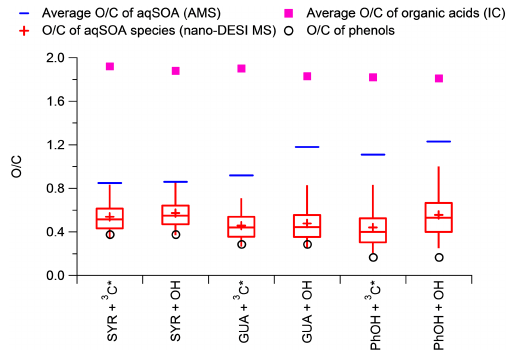
Figure 1. The average O / C ratios of aqSOA formed from the reac- tions of syringol (SYR), guaiacol (GUA), and phenol (PhOH) with 3 C ∗ and · OH, respectively determined by AMS (blue bars) and the average O / C of organic acids determined by IC (pink squares). The distributions of the O / C of individual molecules in the aqSOA de- termined by nano-DESI MS are shown in box plots, in which the whiskers above and below the boxes indicate the 95th and 5th per- centiles, the upper and lower boundaries of the boxes indicate the 75th and 25th percentiles, and the lines in the boxes indicate the median values and the cross symbols indicate the mean values. The O / C of the precursors are shown as black